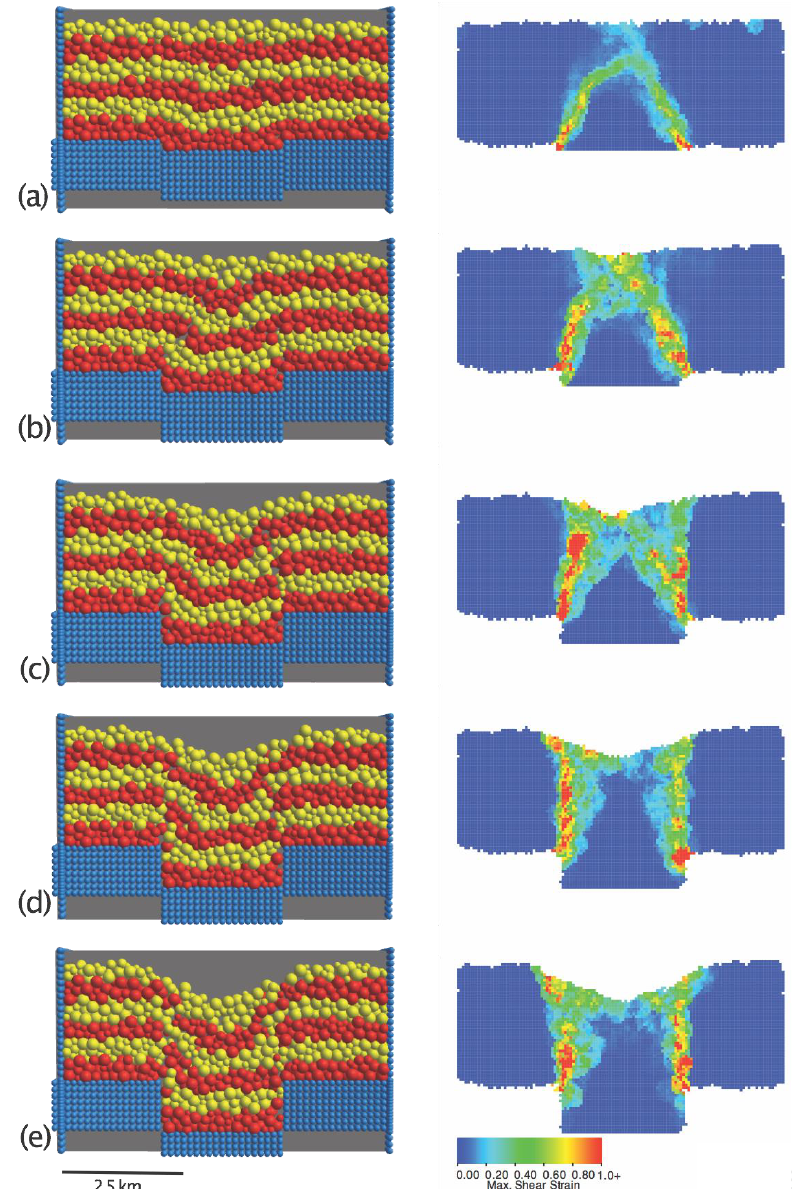
Figure 10. Evolution of vertical section B: caldera geometry (left) and incremental shear strain accrued during the preceding 200 m of basal subsidence (right) at ( a ) 200, ( b ) 400, ( c ) 600, ( d ) 800, and ( e ) 1000 m basal subsidence for an experiment with a flat, rectangular roof.